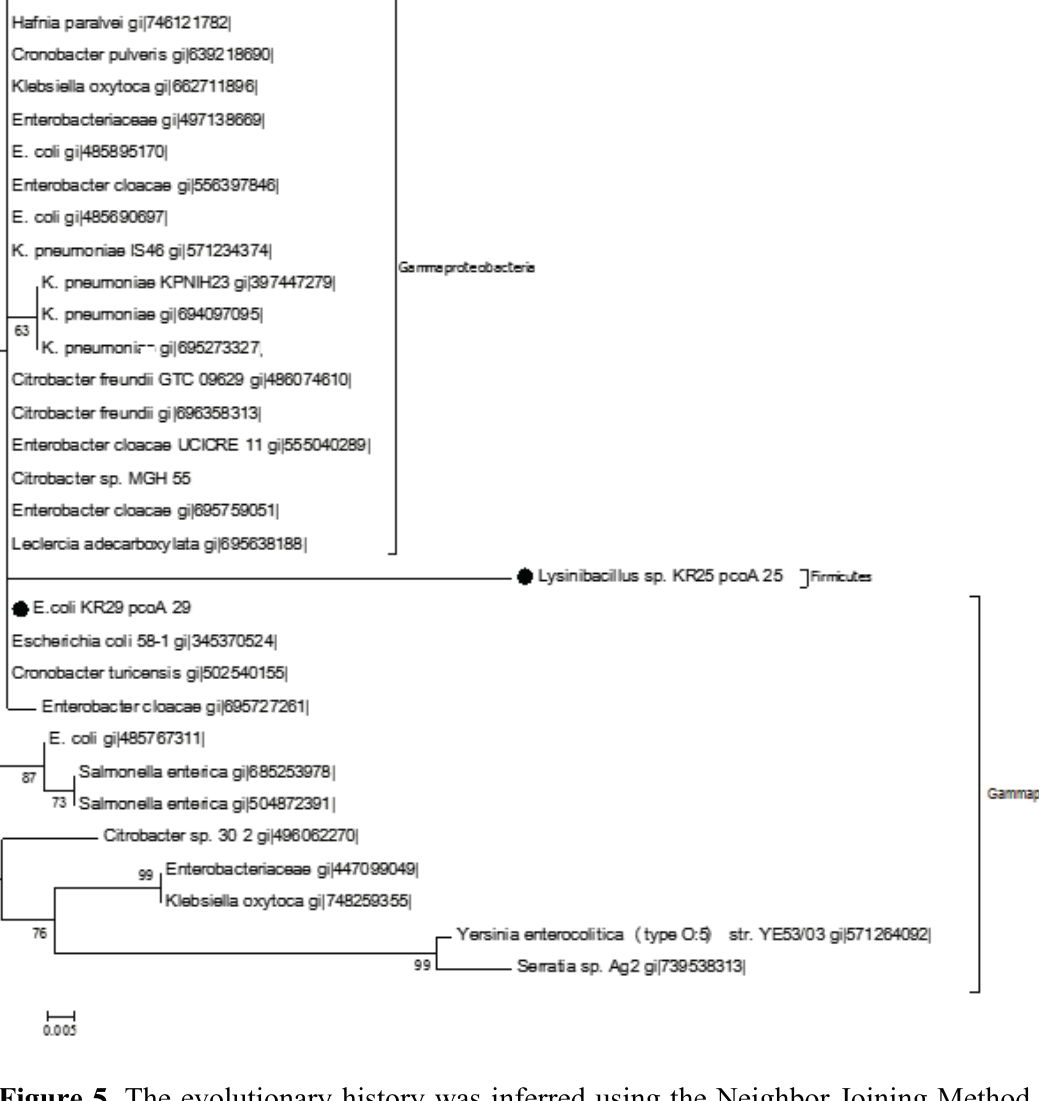
Figure 5. The evolutionary history was inferred using the Neighbor Joining Method [30]. The optimal tree with sum branch length 0.26187151 is shown. The percentage of replicate trees in which the associated taxa clustered together in the bootstrap test (1000 replicates) are shown next to the branches [31]. The evolutionary distances were computed using the p -distance method [32] and are in the units of the number of amino acid differences per site. The analysis involved 30 amino acid sequences. Evolutionary analysis was conducted using MEGA 6 [33]. The markers indicate the protein identified in this